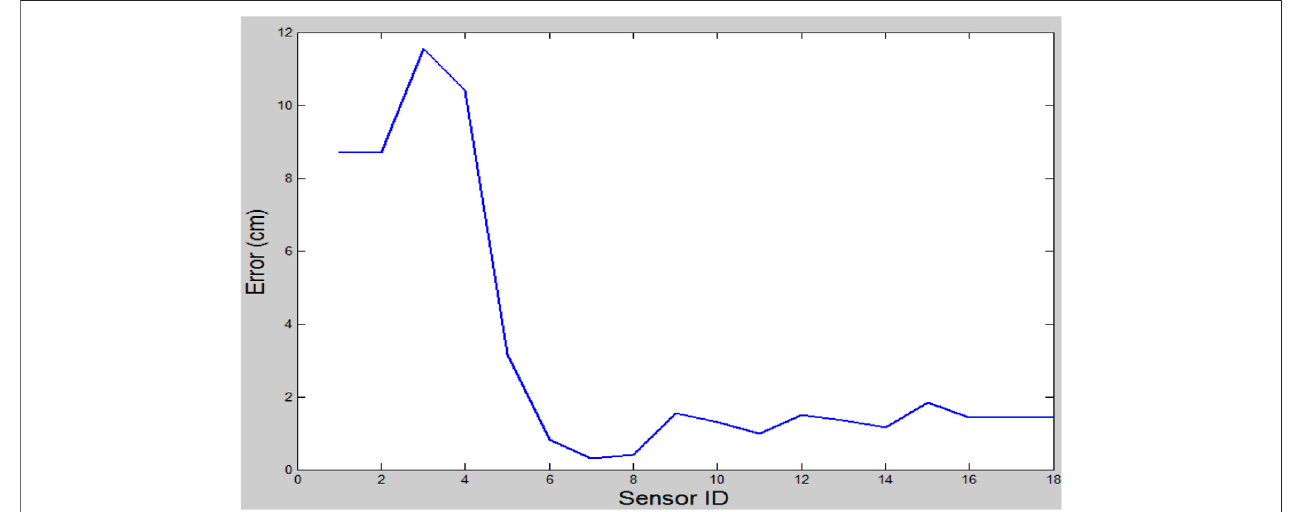
FIGURE 5 | Error in Estimated Position values with the number of sensors.